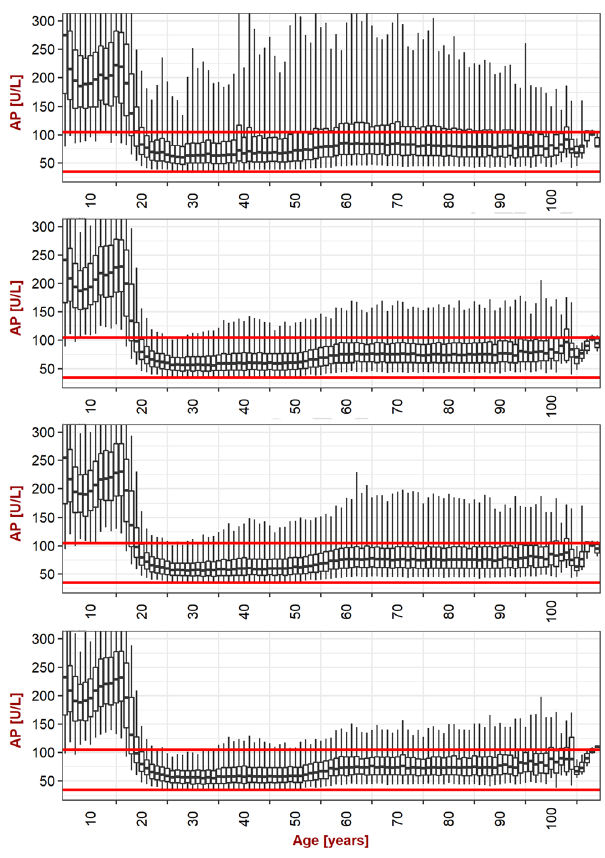
Figure 1: Boxplots of AP-values vs. age for female subjects for the clinical laboratory